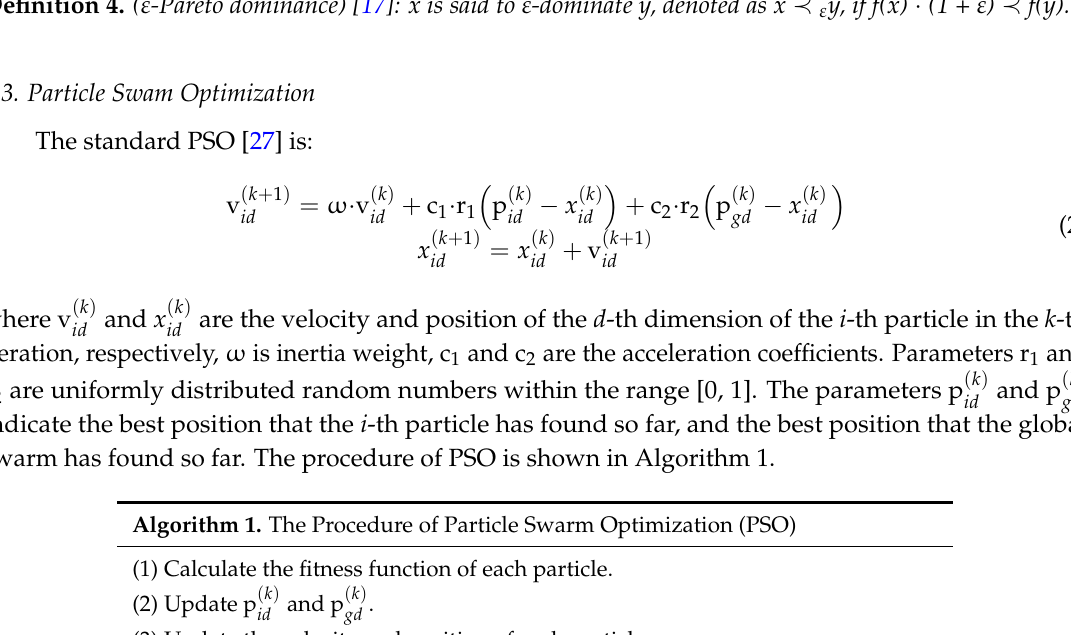
Algorithm 1. The Procedure of Particle Swarm Optimization (PSO)